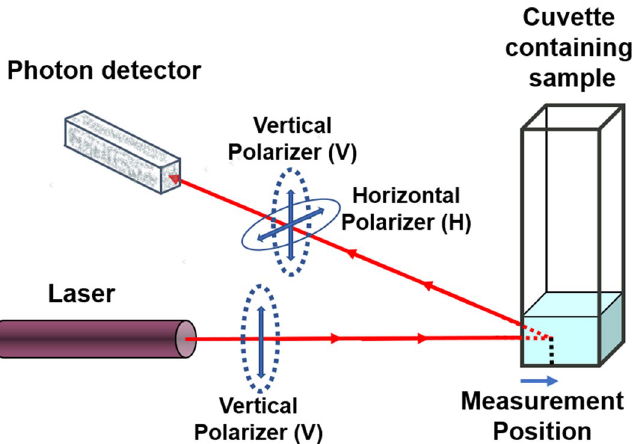
Figure 2. Diagram showing the light from a vertically polarized laser (where the laser is on the same horizontal plane as the photon detector perpendicular to the vertical direction of the cuvette) going through the sample where the measurement position in the cell is noted, followed by the inclusion of the vertical and horizontal polarizers between the cell and photon detector. This is further denoted as VV and VH to reflect the respective input and output